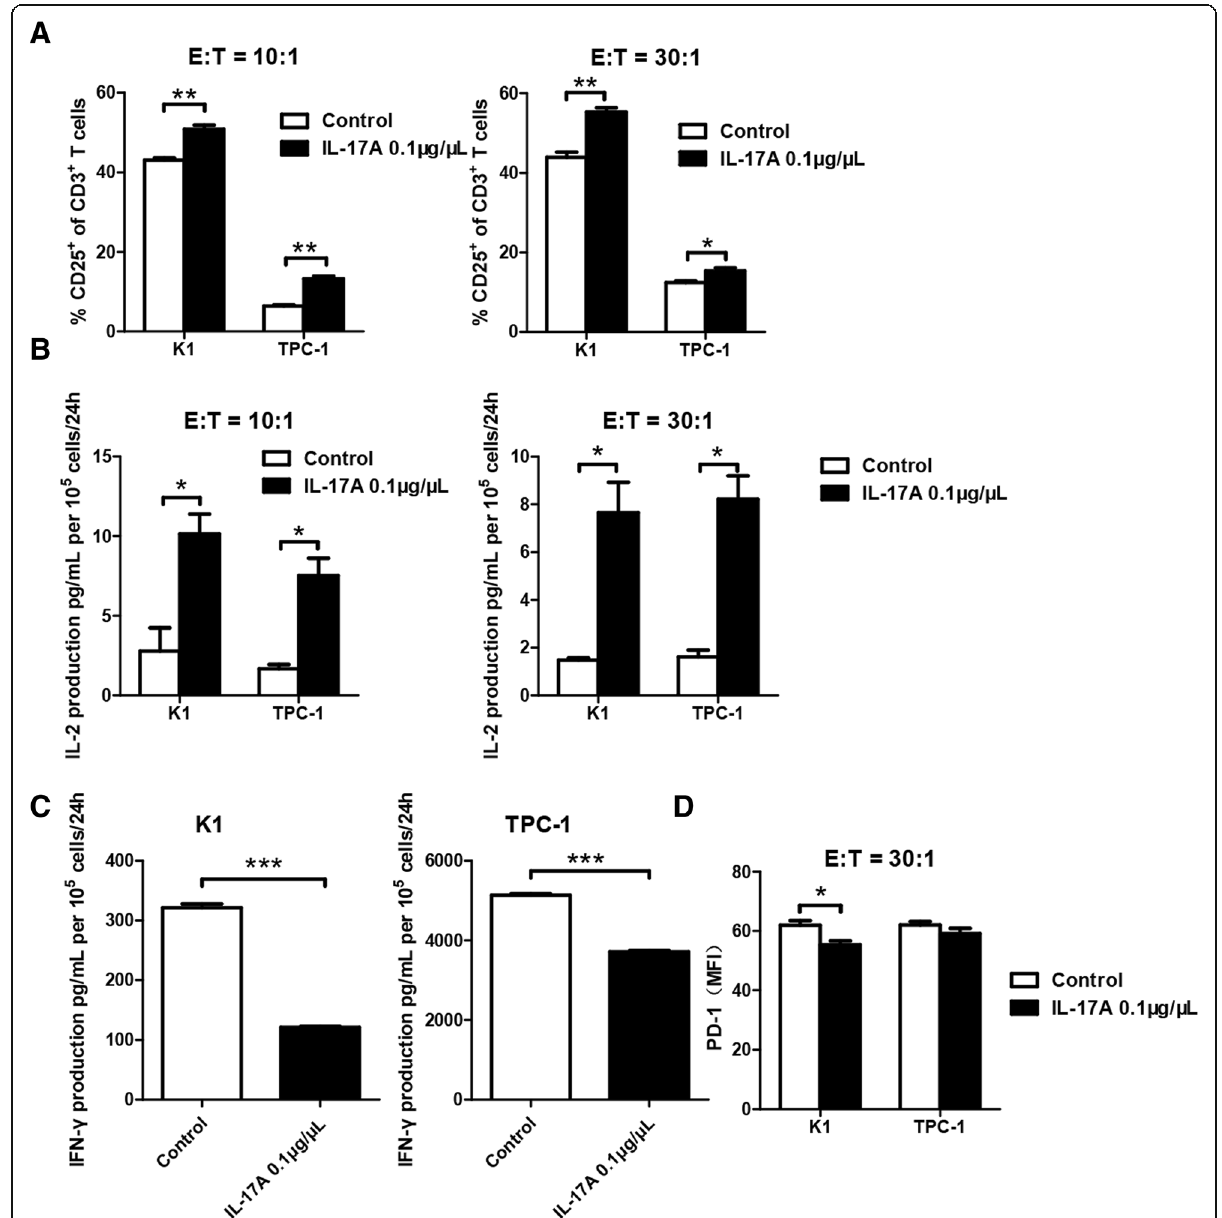
Fig. 4 IL-17A promotes T cell activation in co-cultures of CD3 + CD8 + CD25 + T cells and PTC cell lines. a , flow cytometry measurements of %CD25 + of CD3 + T cells in coculture systems containing CD3 + CD8 + CD25 + T cells (effector cells, E) and pretreated PTC cells (K-1 and TPC-1 treated with 0.1 μ g/ μ L of IL-17A; target cells, T) at various E:T ratio (10:1 and 30:1). ( ** P < 0.01) b , ELISA results of IL-2 production in coculture systems. ( * P <